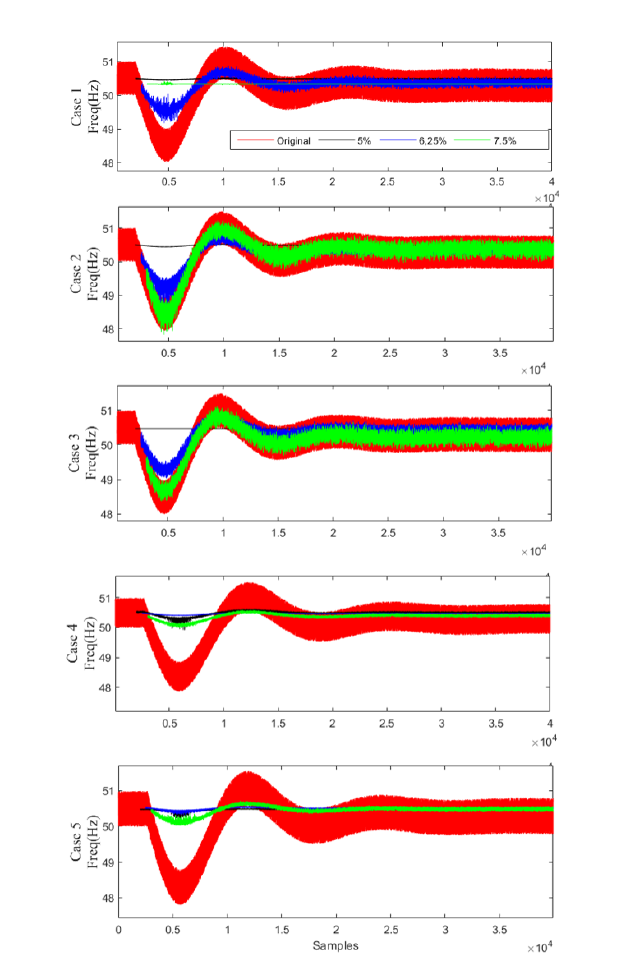
Figure 11. Results for the NAR models in all simulation cases with added